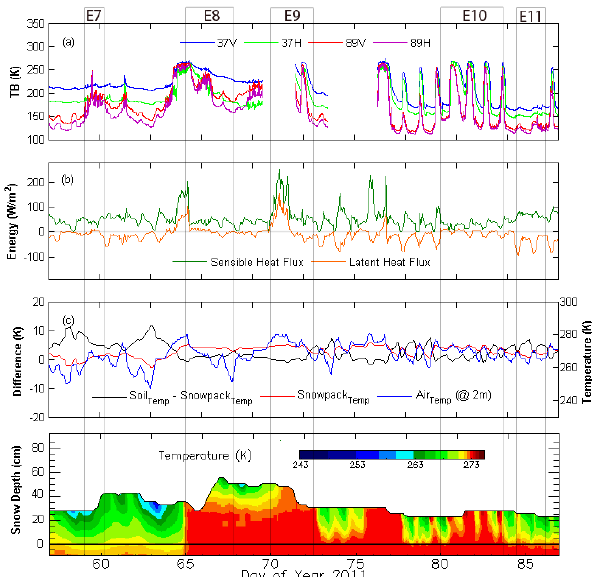
Fig. 5. Time series under melting and refreezing phase during late winter period of warm days (wet snow) and cold nights. The quan- tities shown are the same as those described in Fig.